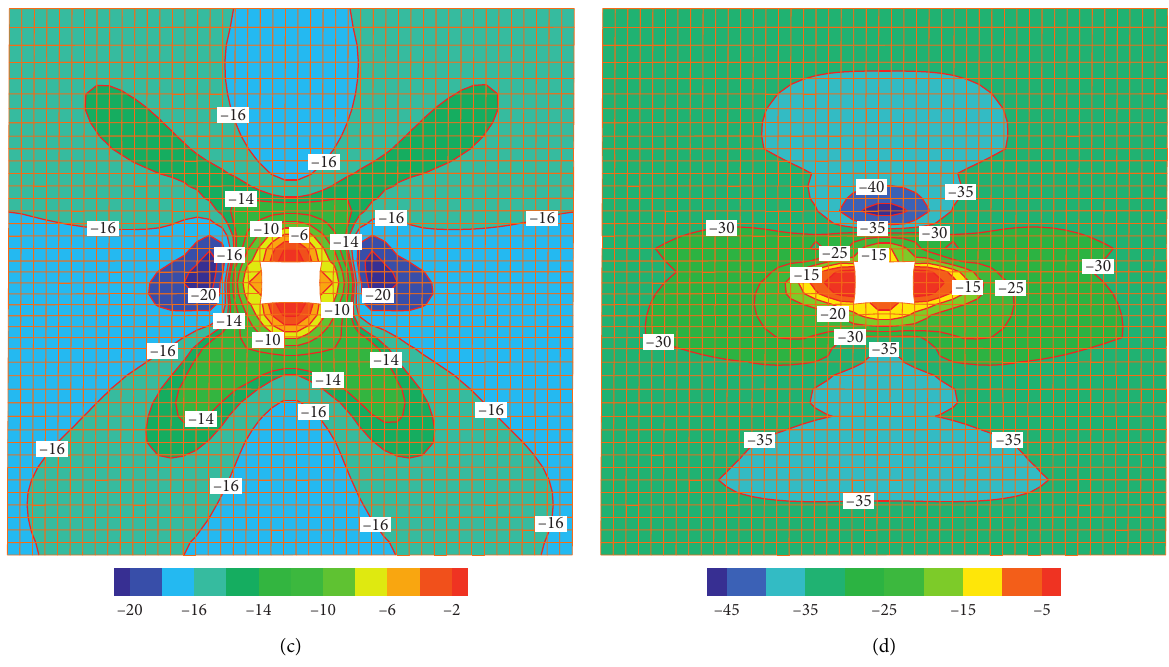
Figure 18: Cloud diagram of the roadway stress. (a) Vertical stress with no support; (b) horizontal stress with no support; (c) vertical stress with support; and (d) horizontal stress with support.